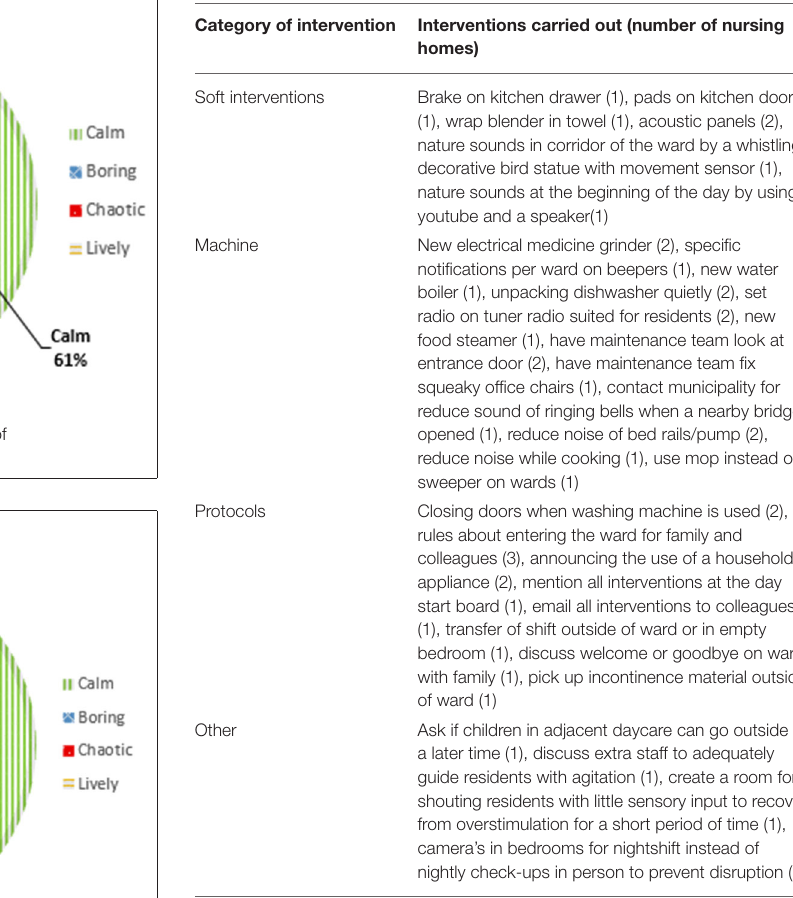
TABLE 2 | Micro-interventions carried out during the study in the nursing